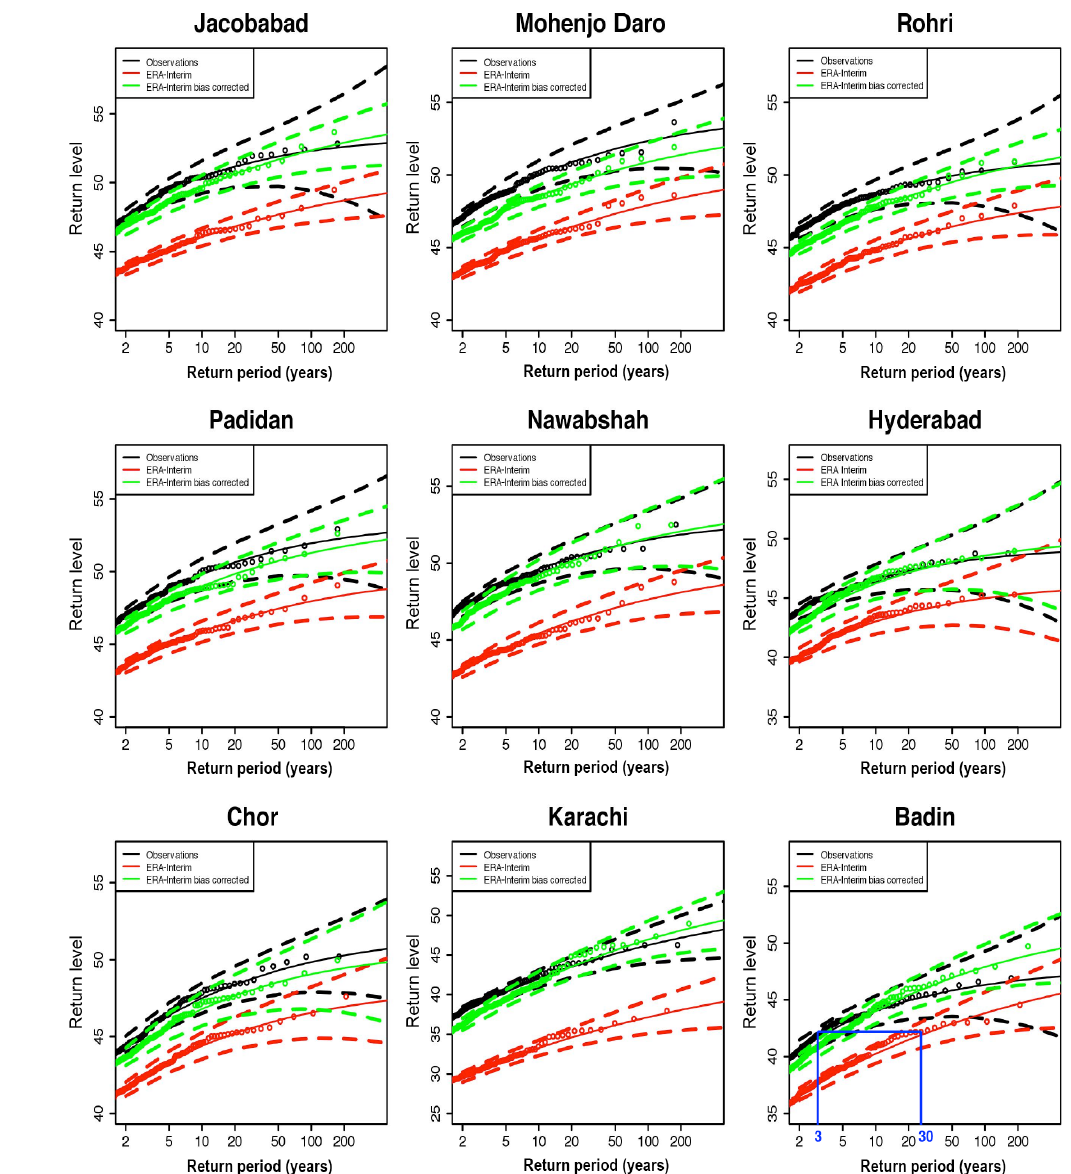
Figure 6. Return level plots of the station-observed T max (black), ERA-Interim T max (red), and bias-corrected ERA-Interim T max (green) in degrees Celsius. The blue line is to show a difference in the observed and ERA-Interim